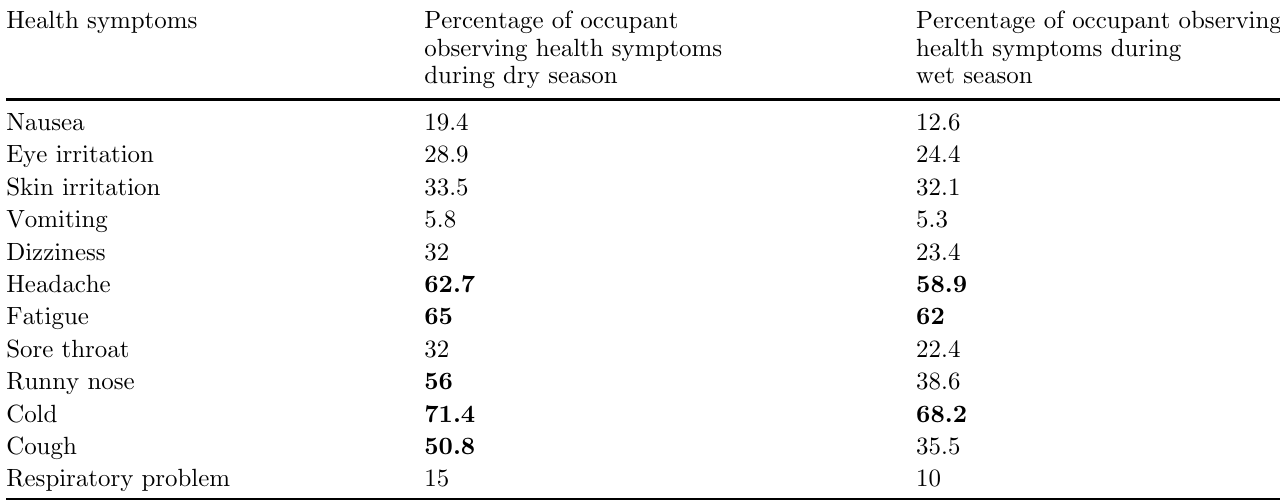
Table 12. Frequency of observing IAQ related health symptoms among respondents. Health symptoms Percentage of